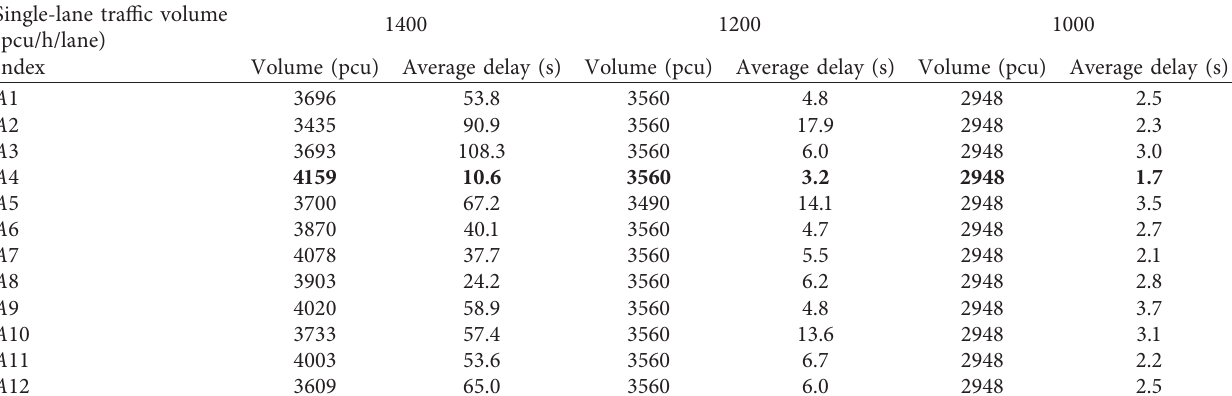
Table 3: Results of lane-changing simulation plans.